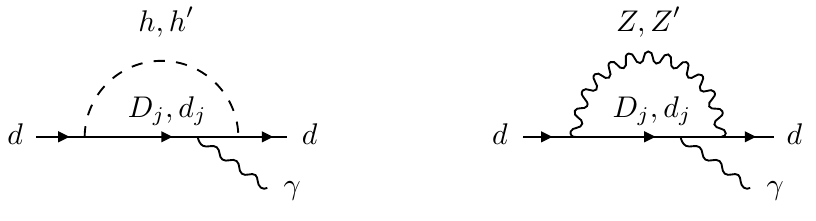
Figure 3 . One-loop diagrams generating a non-zero EDM for the d quark in the presence of soft breaking of generalized parity through non-hermitian vector-like mass matrices for the SU(2) - singlets. The leading contribution arises from the diagram where h 0 , and the heavy mirror quarks, D j , propagate inside the loop. Analogous diagrams are present in both the up-quark and lepton